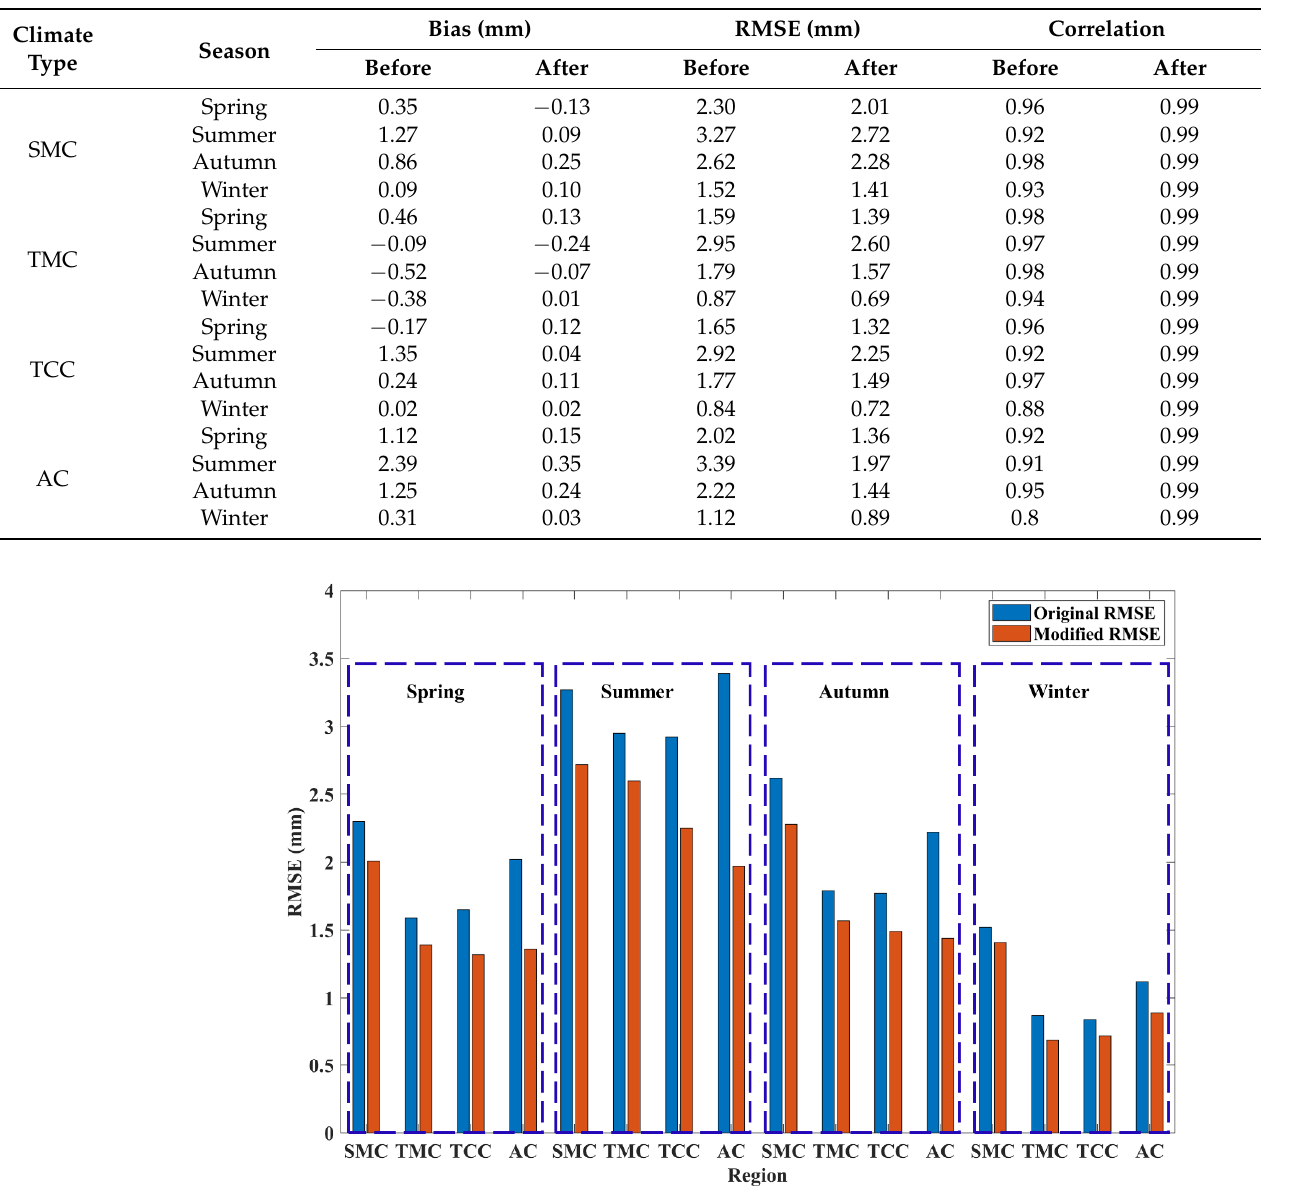
Figure 7. Comparison of the RMSE between the original ERA5 PWV and modified ERA5 PWV. As shown in Table 2 and Figure 6, after the correction of the fusion model, the absolute bias of the ERA5 PWV in each period was less than 0.4 mm, which mainly fluctuated near 0. Figure 7 shows the RMSE of different regions in all time periods before and after the model calibration. Overall, the RMSE of the ERA5 PWV decreased from 2.05 mm to 1.67 mm, an improvement of 18.54%. The average overall RMSE decline in each season was 0.37 mm (spring), 0.74 mm (summer), 0.41 mm (autumn), and 0.16 mm (winter), and the corresponding improvement rates were 10.62%, 18.76%, 15.68%, and 13.49%, respec- tively. The RMSE of each region decreased by 0.33 mm (SMC), 0.23 mm (TMC), 0.35 mm (TCC), and 0.78 mm (AC), and the corresponding improvement rates were 10.62%, 12.19%, 13.57%, and 27.33%, respectively. At the same time, the correlation coefficient be- tween the corrected ERA5 PWV and GNSS PWV increased to 0.99. The above statistical data show the applicability of the model at the temporal scale, especially for the summer with a larger RMSE and the AC area with poor accuracy. Figure 8 also shows the correc- tion rate of the ERA5 PWV after correction at each station.